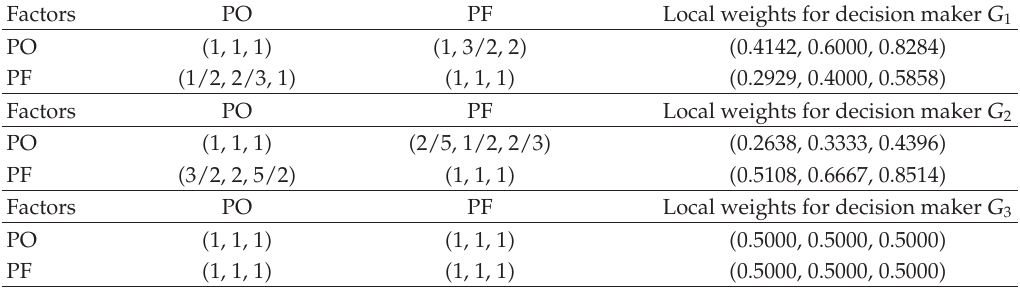
Table 4: Local weights and pairwise comparison matrix of factors.